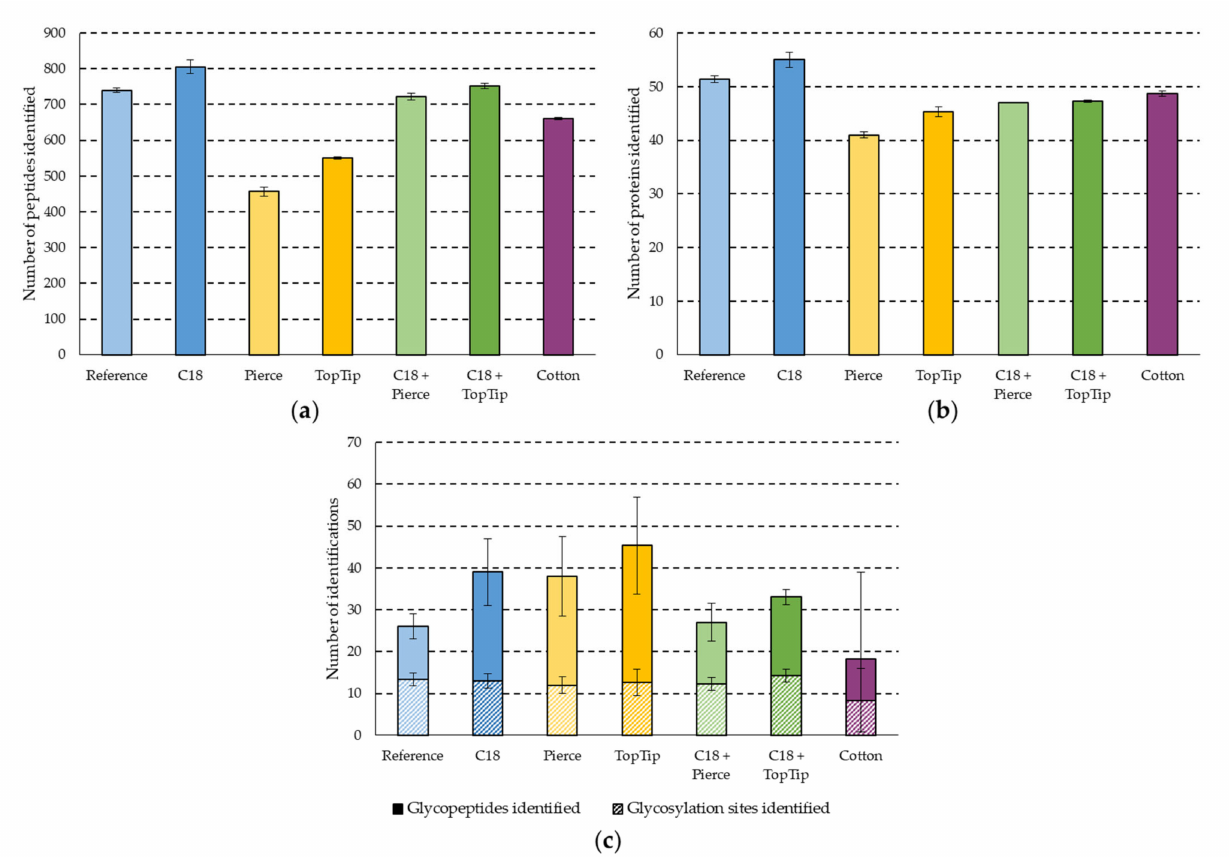
Figure 2. The number of peptides ( a ), proteins ( b ), and glycopeptides and glycosylation sites ( c ) detected with each SPE clean up method. Samples were measured in triplicate; error bars represent standard